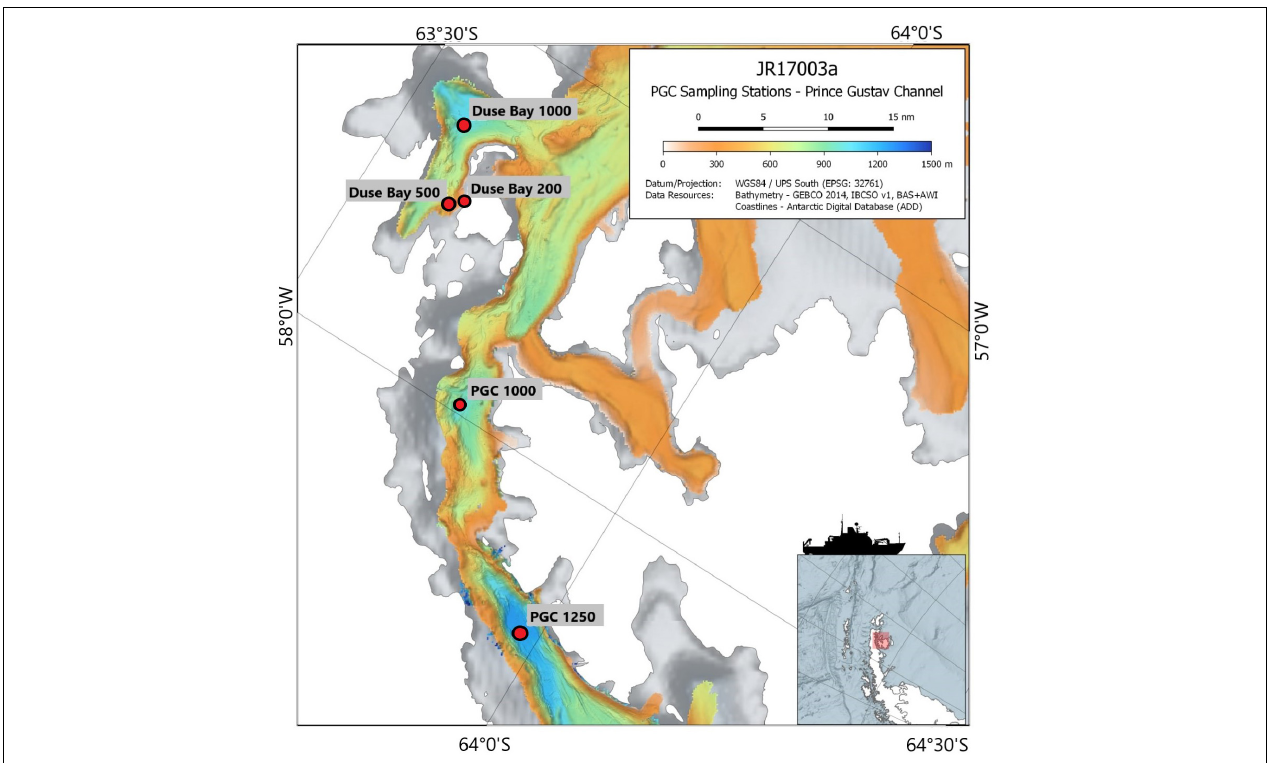
FIGURE 1 | Sampling stations in the Prince Gustav Channel (PGC, 1,000 and 1,250 m) and Duse Bay (DB, 1,000, 500, and 200 m). Bathymetric map courtesy of: “British Antarctic Survey” and “Bathymetry Group of the Alfred-Wegener-Institute.”